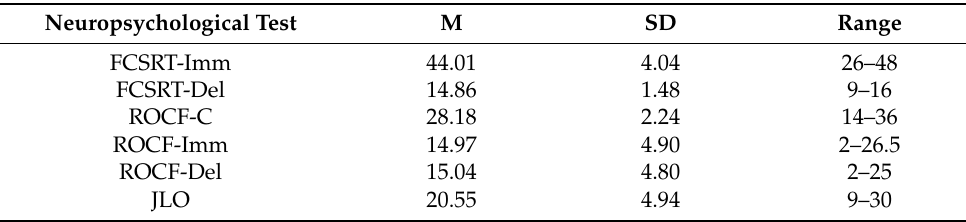
Table 1. Descriptive statistics for neuropsychological performance.